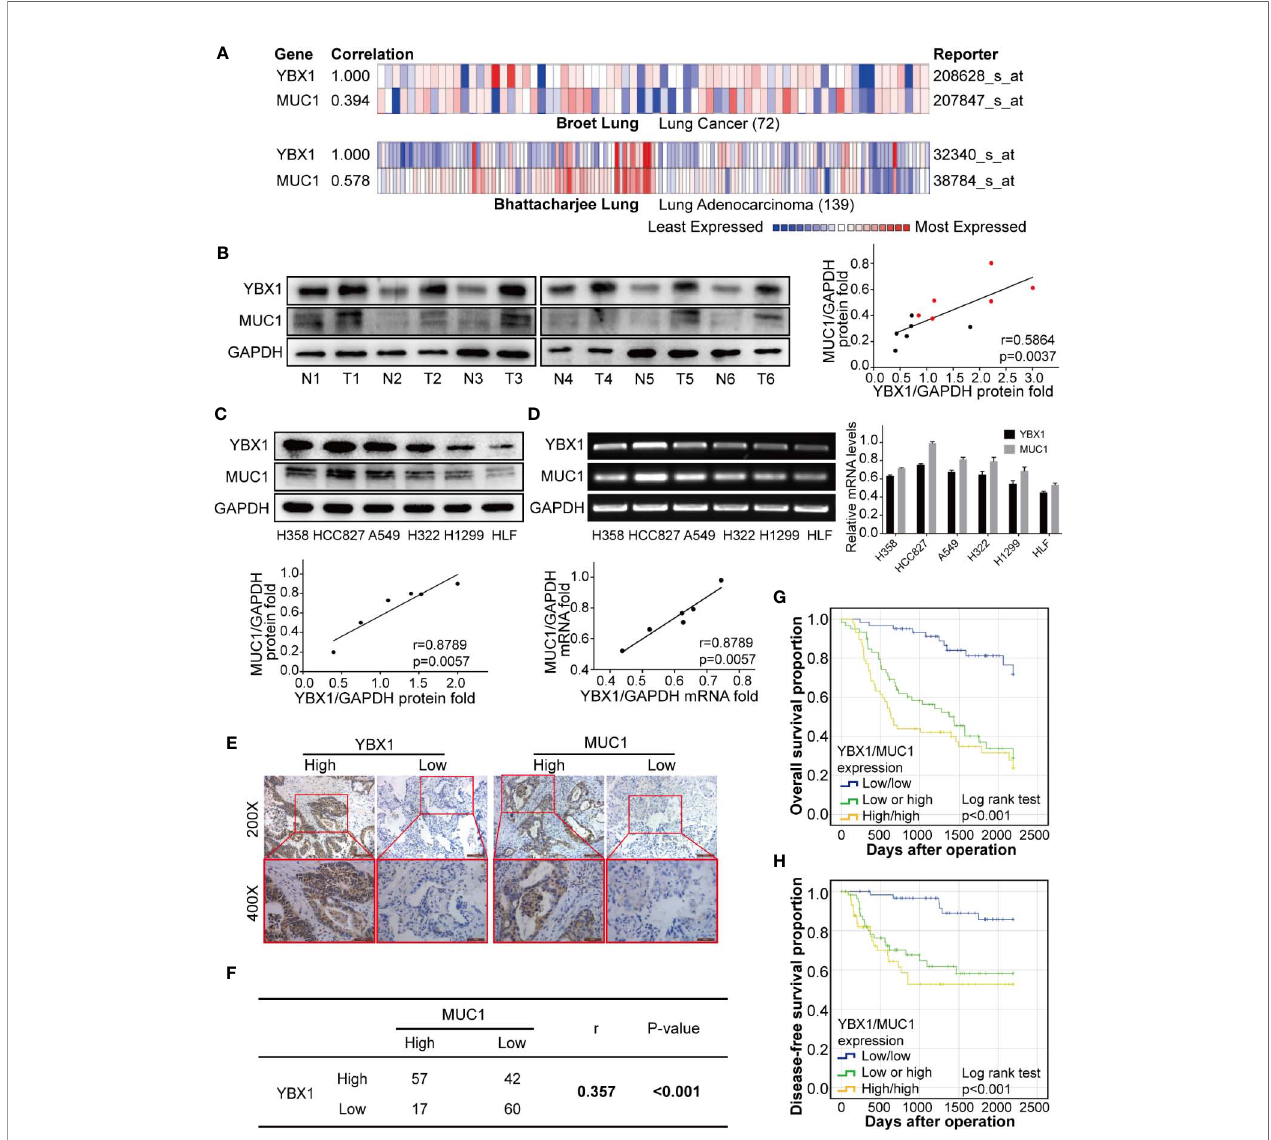
FIGURE 1 | YBX1 and MUC1 expression was the highly correlated and affected prognosis. (A) YBX1 and MUC1 mRNA expression were based on the Broet Lung and Bhattacharjee Lung datasets from the Oncomine database (p<0.05, p<0.05, respectively). (B) Western blot analysis of YBX1 and MUC1 expression in 6 pairs of lung adenocarcinoma (T) and adjacent tissues (N) (r = 0.5864, P < 0.0037, Red dot: T, Black dot: N). (C) Western blot analysis of YBX1 and MUC1 expression in HLF and 6 lung adenocarcinoma cell lines (r = 0.8789, P < 0.0057). (D) RT-PCR analysis of YBX1 and MUC1 expression in HLF and lung adenocarcinoma cell lines (r = 0.9306, P < 0.0018). (E) IHC analysis of YBX1 and MUC1 expression in lung adenocarcinoma. Original magni fi cation 200× and 400× in the inset. (F) YBX1 and MUC1 expression was positive correlated in 176 lung adenocarcinoma specimens (r = 0.357, P < 0.001). (G) The OS curves of YBX1/MUC1 expression in 176 patients with lung adenocarcinoma (p <0.001). (H) The DFS curves of YBX1/MUC1 expression in 176 patients (p <0.001). The data are presented as mean ± SD of three independent